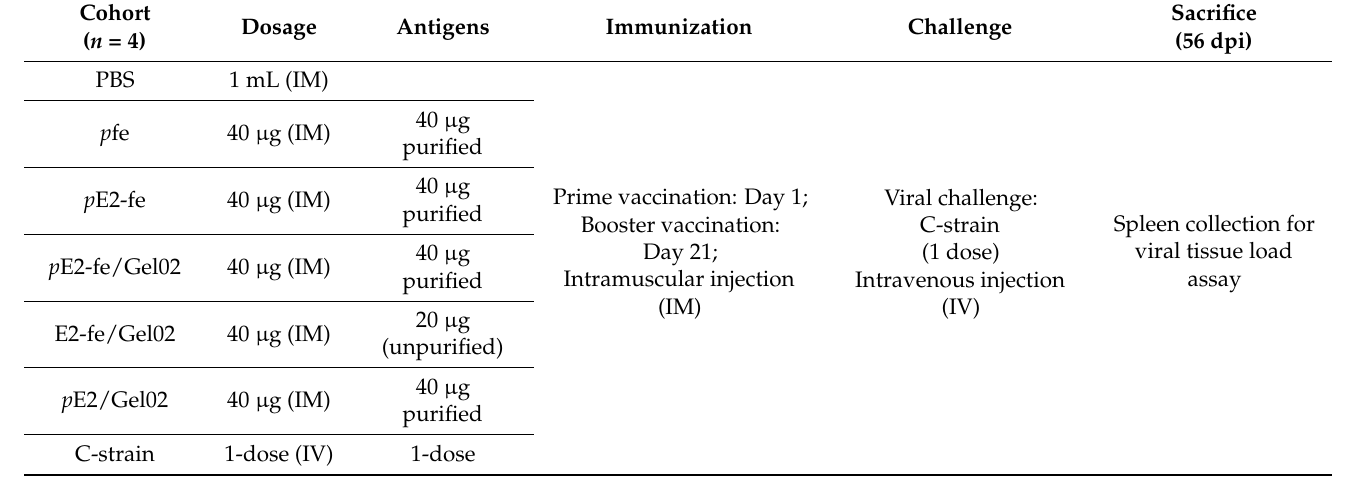
Table 2. Immunization procedure and dosages in the ATR evaluation model.